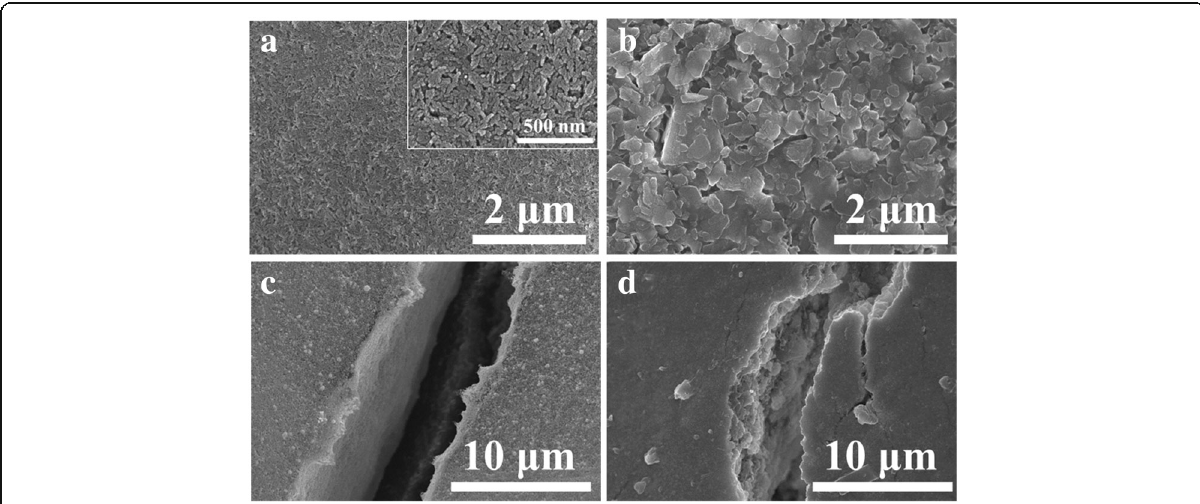
Fig. 10 a , b Surface morphologies of the photopaper and art coated paper. c , d The microstructure of the Ag NP coating on photopaper and coated paper respectively